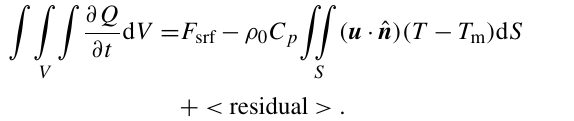
ρ 0 = 1025 kg m − 3 is the reference density. Figure 4b–d